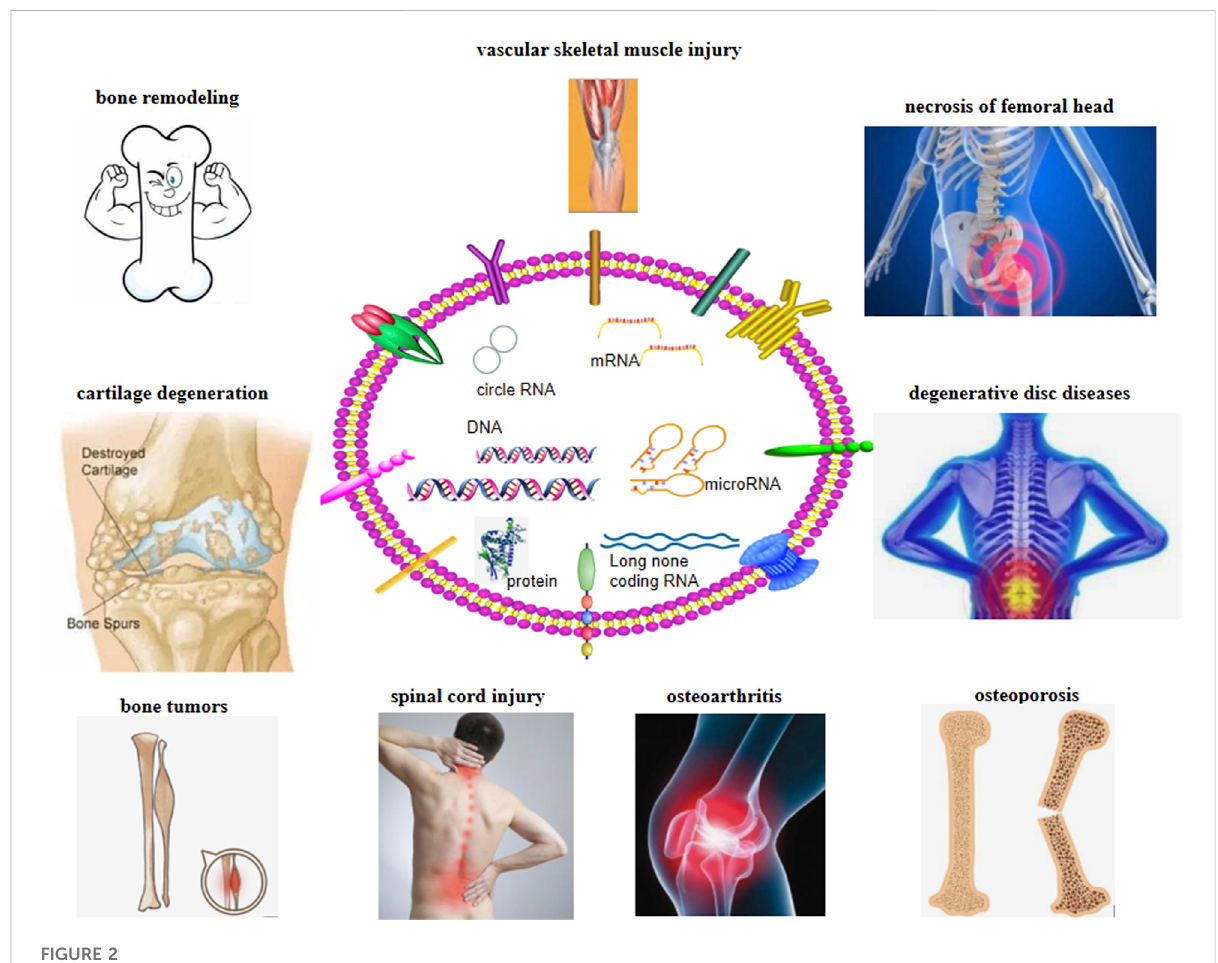
FIGURE 2 Research progress of exosomes in